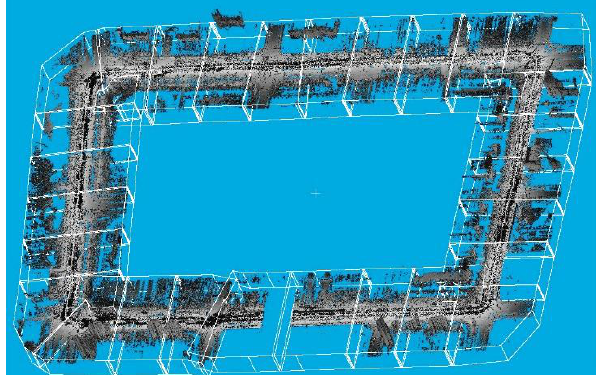
Figure 3. Partitioning terrestrial LiDAR point clouds into overlapping sequential